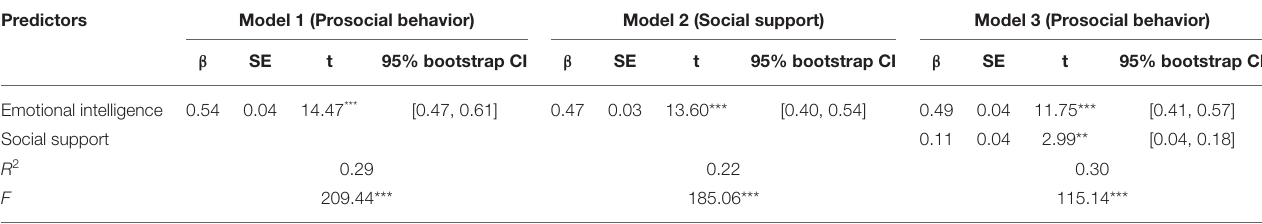
TABLE 2 | Testing the mediation effect of social support between emotional intelligence and prosocial behavior.